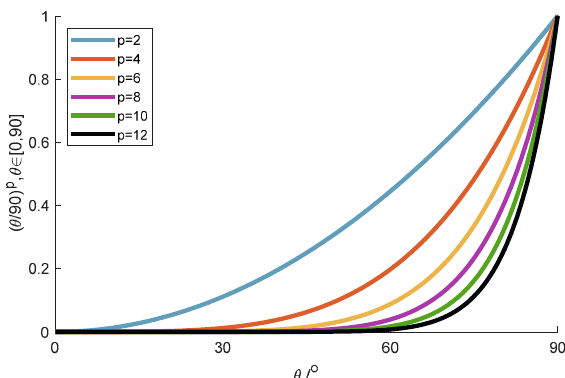
Figure 6. Shape of the parameter α = ( θ /90 ) p , θ ∈ [ 0,90 ] , with di ff erent choices of p